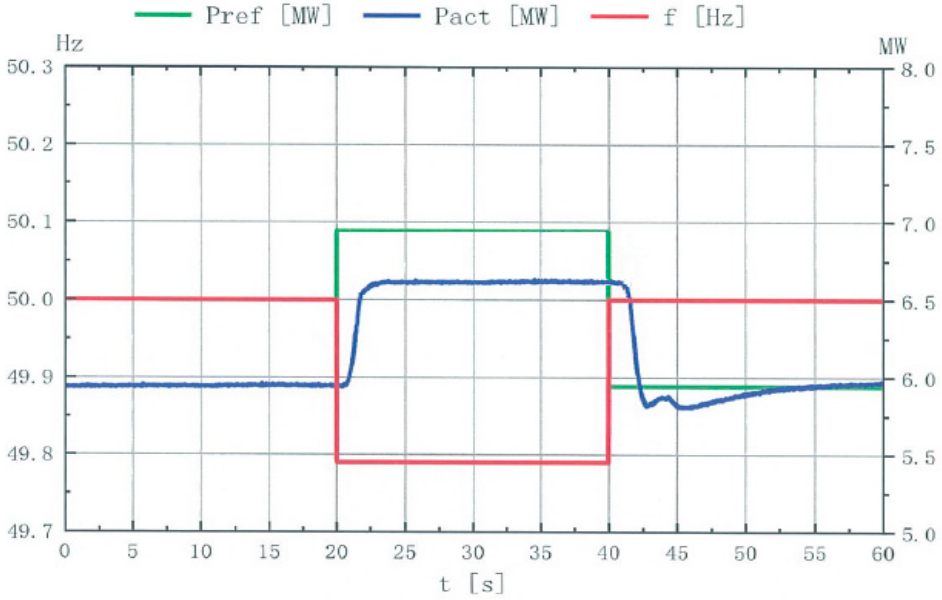
Figure 8. Frequency downward step with unsuccessful FFR (average) response waveform.